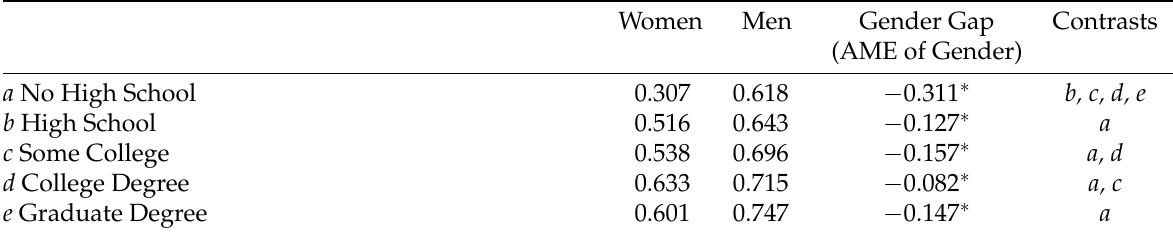
Table 4: Probability of alcohol use by gender and education: marginal effects of gender and differences in effects of gender across levels of education ( N = 4,